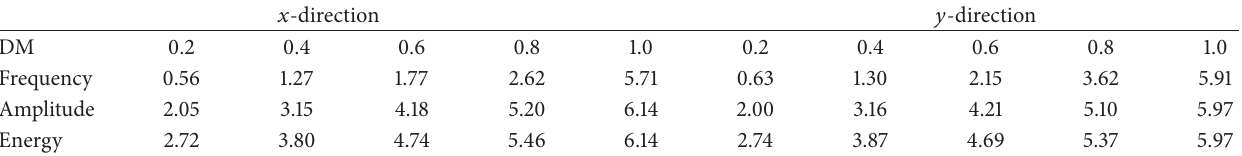
Table 5: Median values of damage